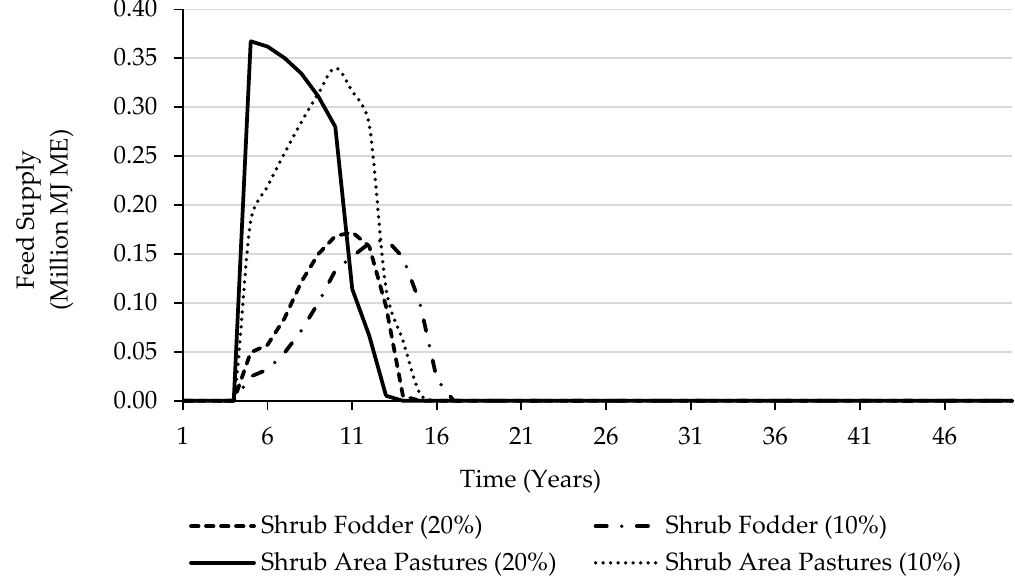
Figure 3. Total shrub forage (shrub fodder, understory, and open pastures) in metabolizable energy (million megajoules) per year for 50 years, on 10% of the modelled farm planted in native shrubs at 10% and 20% per year planting rates.